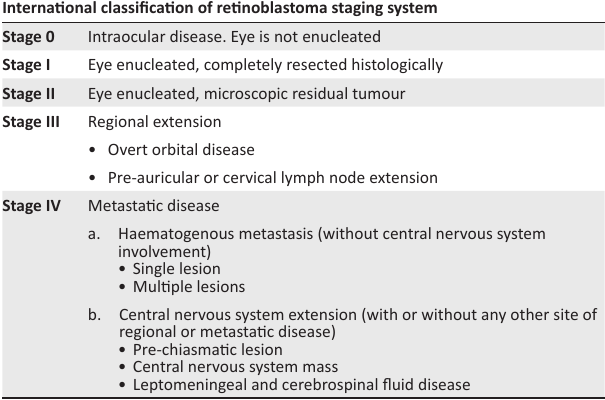
TABLE 2: The International Classification of retinoblastoma staging system. 4 International classification of retinoblastoma staging